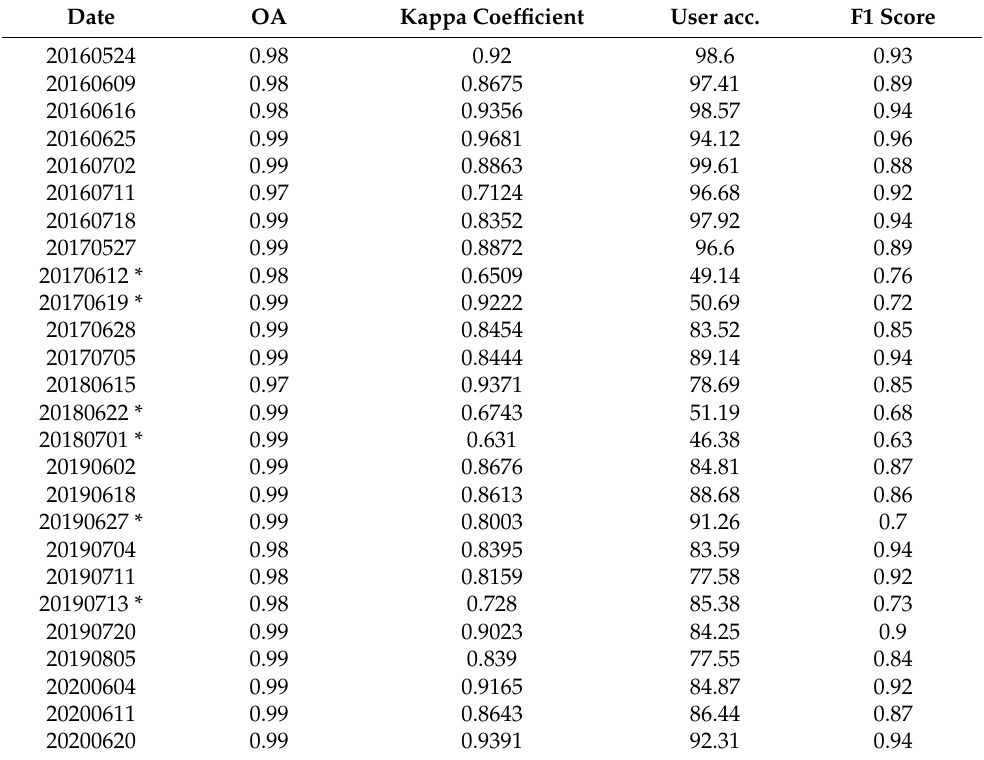
Table 4. Confusion matrix of FAI-COM and